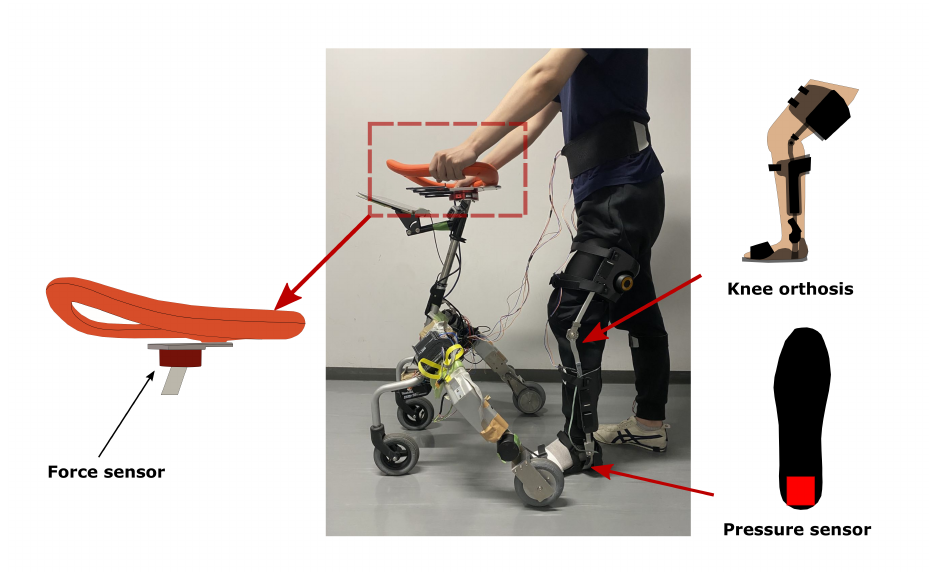
Figure 7. Walker used in